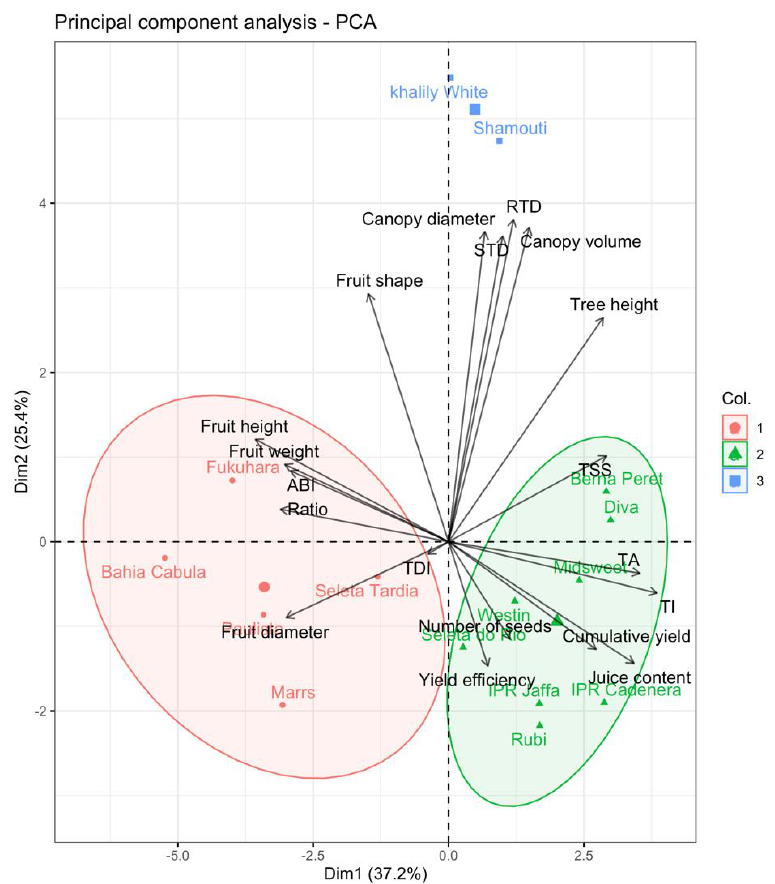
Figure 2. Principal component analysis (PCA) for vegetative growth, yield, and fruit quality variables of young trees of 15 early-season and mid-season sweet orange cultivars. The variables were arranged according to their principal component scores and the individuals (sweet orange cultivars) were grouped into three distinct clusters (Col.): 1, 2, and 3. Variables: tree height (m); canopy volume